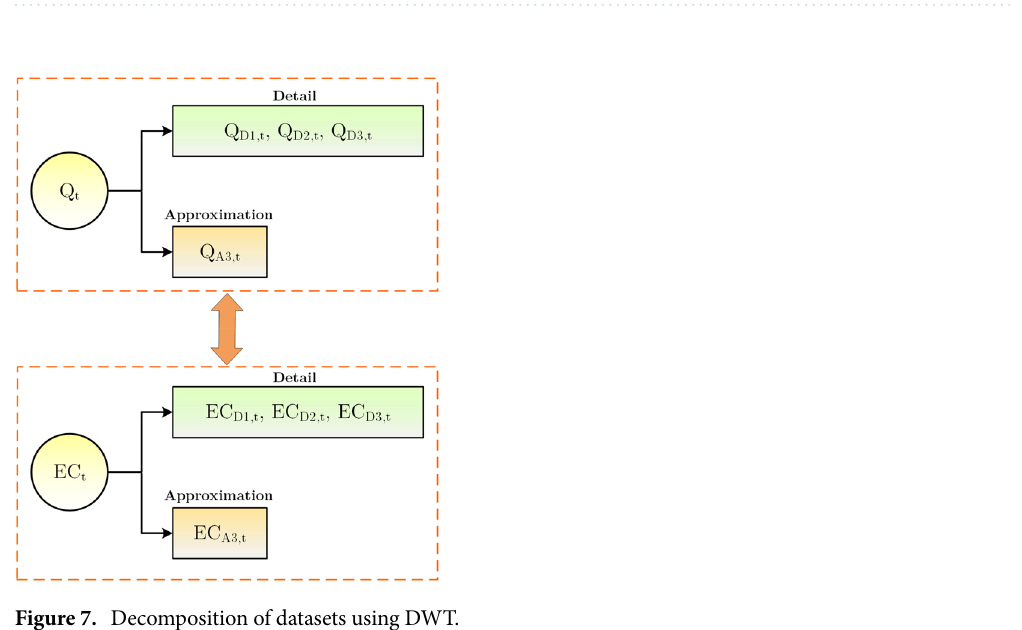
Table 3. Control parameters of the LSSVM, MARS, and GRNN models.